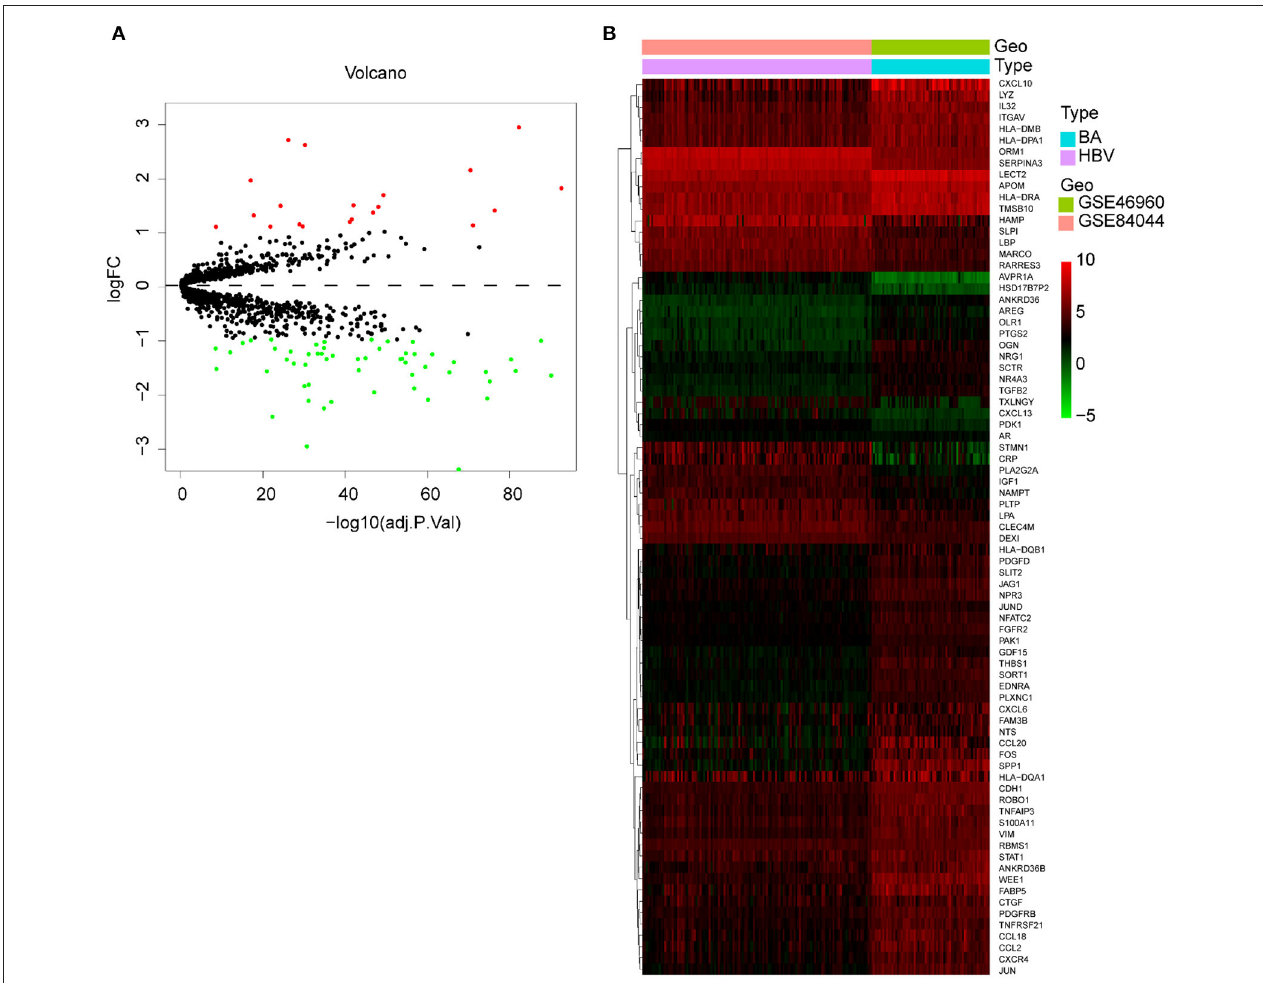
FIGURE 9 | DE-IGs between BA and viral hepatitis B. (A) The volcano plot of 75 DE-IGs. The red plots represent upregulated genes and the green plots represent downregulated genes. (B) The heatmap reflects the relative expression of DE-IGs in different individuals and the overall difference between the two